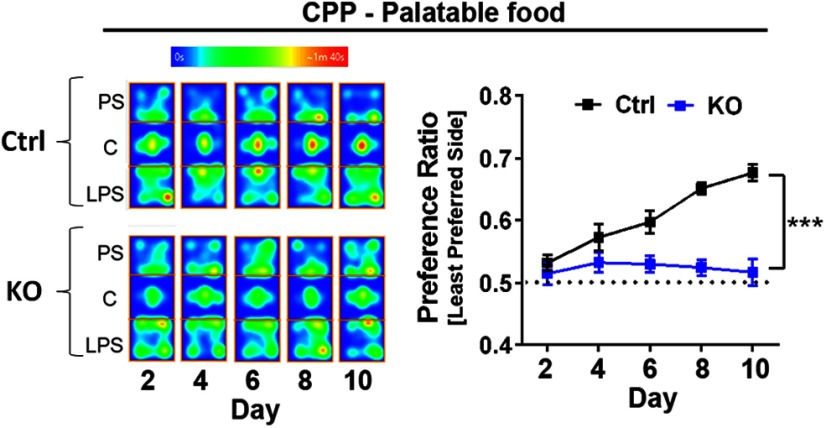
Cue-reward spatial association to palatable food is impaired in ErbB4 KO mice. To evaluate for spatial-cue associations to rewards, a five-test design (days 2, 4, 6, 8, and 10) was used to allow assessment of the development of a CPP to palatable food rewards. Food-restricted mice were conditioned to receive palatable food rewards (14-mg dustless pellets, BioServ) in a previously assigned LPS of the apparatus versus no food at the PS in two consecutive training sessions at days 1, 3, 5, 7, and 9. The left panel is a representative heat map of ErbB4 KO (KO) and control (Ctrl) mice exploring the PS, center (C), and LPS of the apparatus across test sessions and the right panel shows the preference ratio of mice to develop CPP. Control mice (n = 15) progressively conditioned across sessions to spent more time in the LPS, yet ErbB4 KO mice (n = 16) did not develop spatial-cue associations to palatable food rewards (two-way ANVOA genotype effect: F(1,29) = 32.78, p < 0.0001, two-way ANVOA time effect: F(4,116) = 8.619, p < 0.0001). Data represents the mean ± SEM; ***p < 0.005.